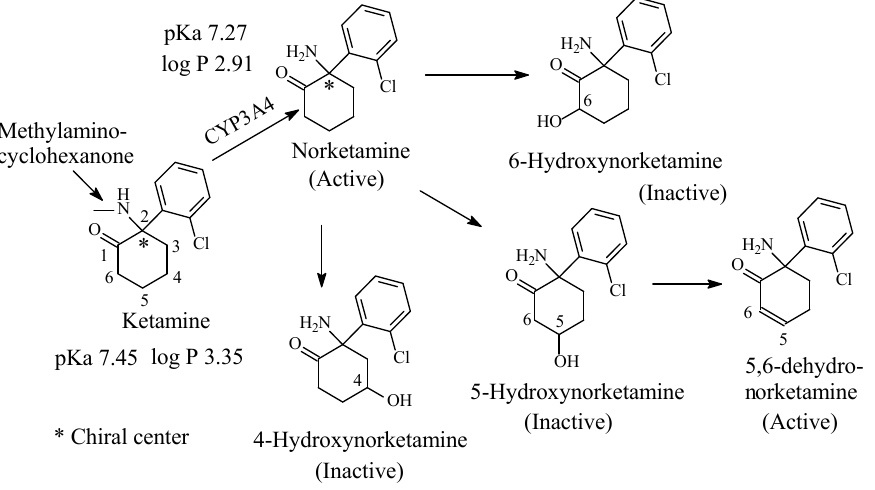
Figure 19. Metabolic pathways of ketamine.